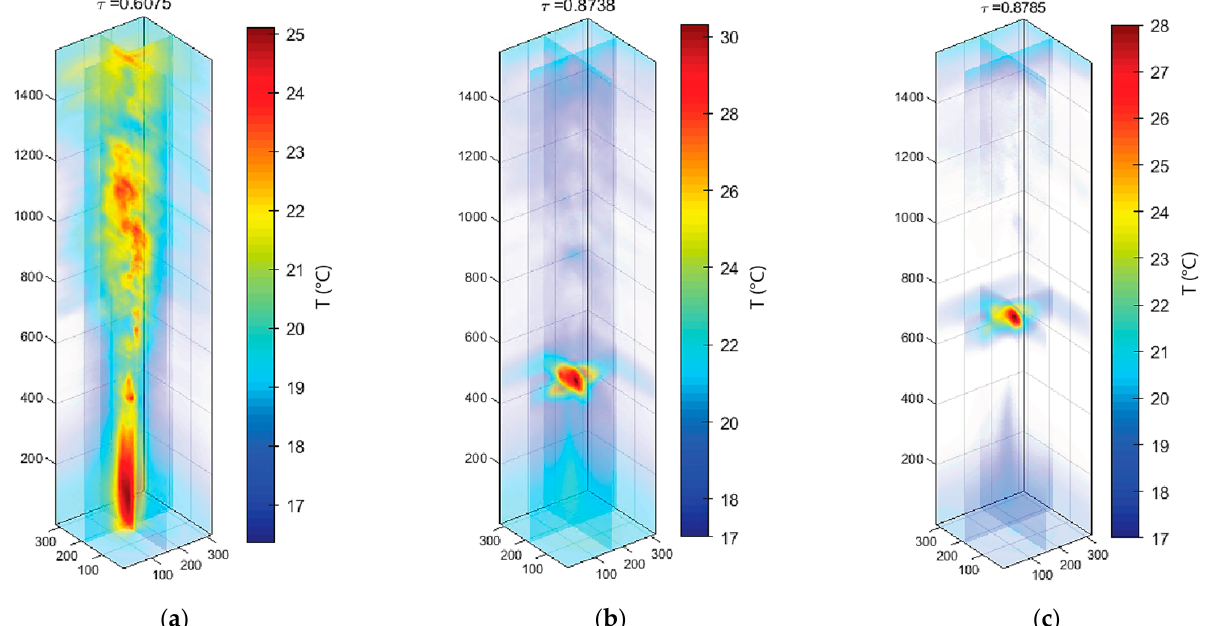
Figure 6. ( a–c ) Tomographic reconstruction at three different instants. However, the condition on symmetry is not fully met. The averaging of many phase fields during the steady flow stage, results in the suppression of the signal fluctuation (random) component. The averaged phase profile over 15 consecutive frames is shown in Figure 7. The averaging time is 1.47 s and thus faster random components are suppressed.